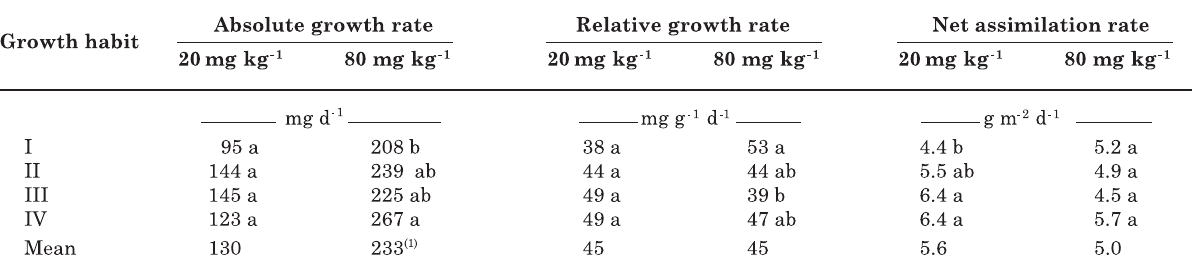
Table 3. Absolute growth rate, relative growth rate, and net assimilation rate of 24 common bean genotypes grouped by growth habit, grown at two P level applied to the soil (20 and 80 mg kg -1 of P), at the 11 day interval between pod setting and early pod